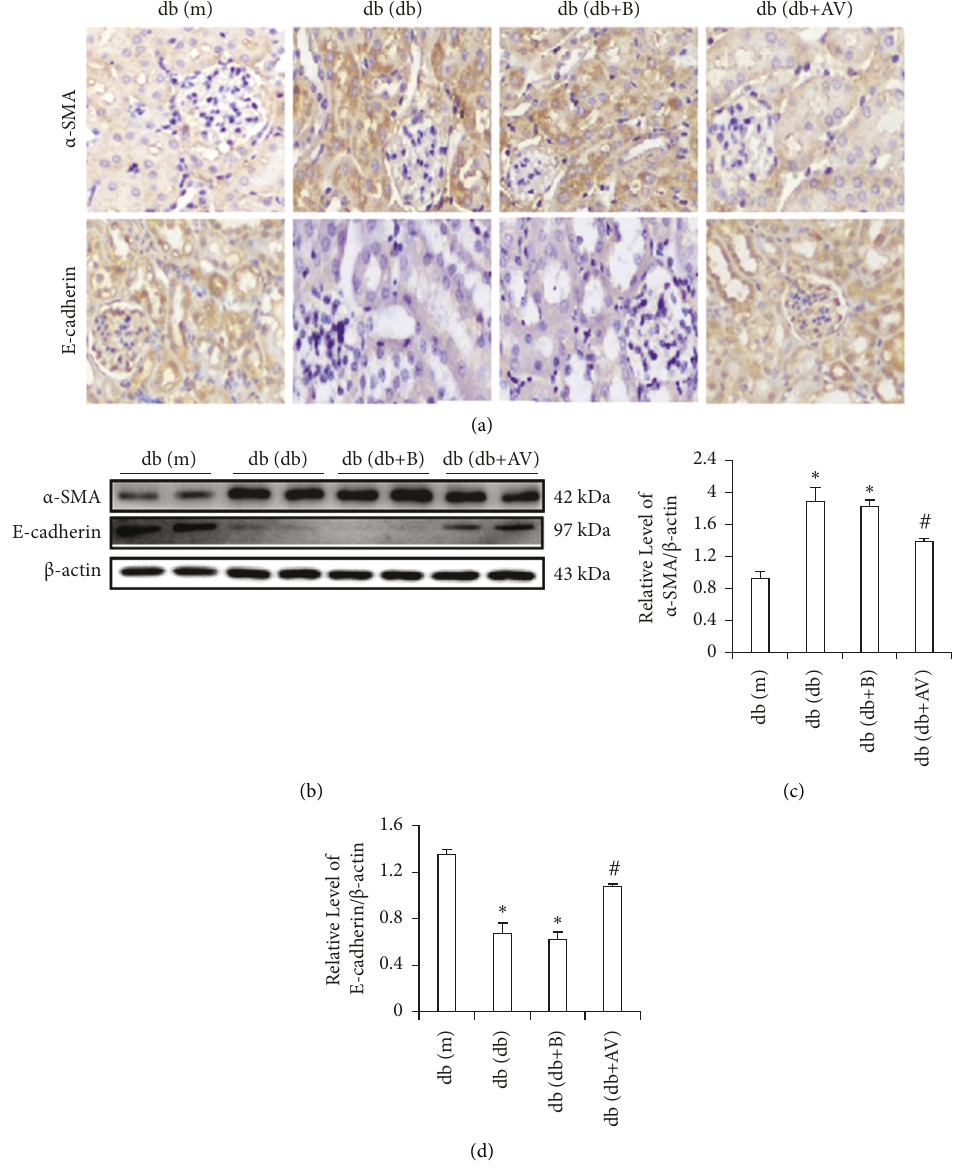
Figure 4: REDD1 deficiency suppresses EMTof RTEC in diabetic mice. (a) Immunohistochemistry examined the expression of α -SMA and E-cadherin (scale bar, 50 μ m). (b, c, d) The expression of α -SMA and E-cadherin was determined by western blot analysis. Values are P expressed as means SD ( n 5 per group). 0 . 05 versus db/m group; # P 0 . 05 versus db/db and db/db+ B (cid:31) ∗ ± < <